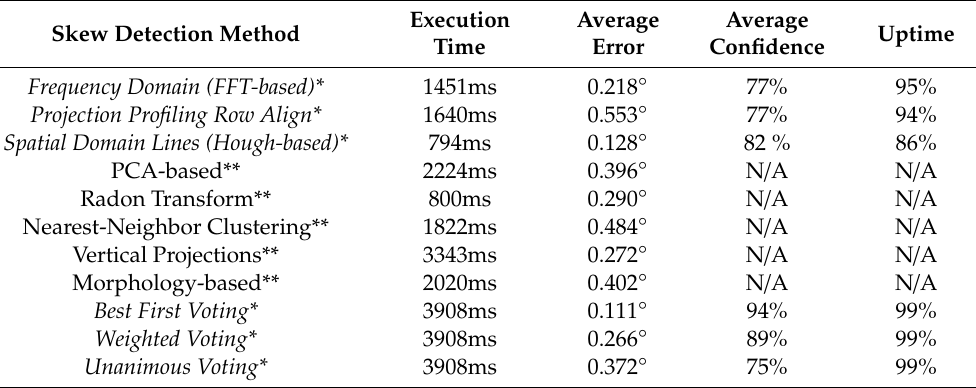
Table 1. Test results for the proposed skew detection system.